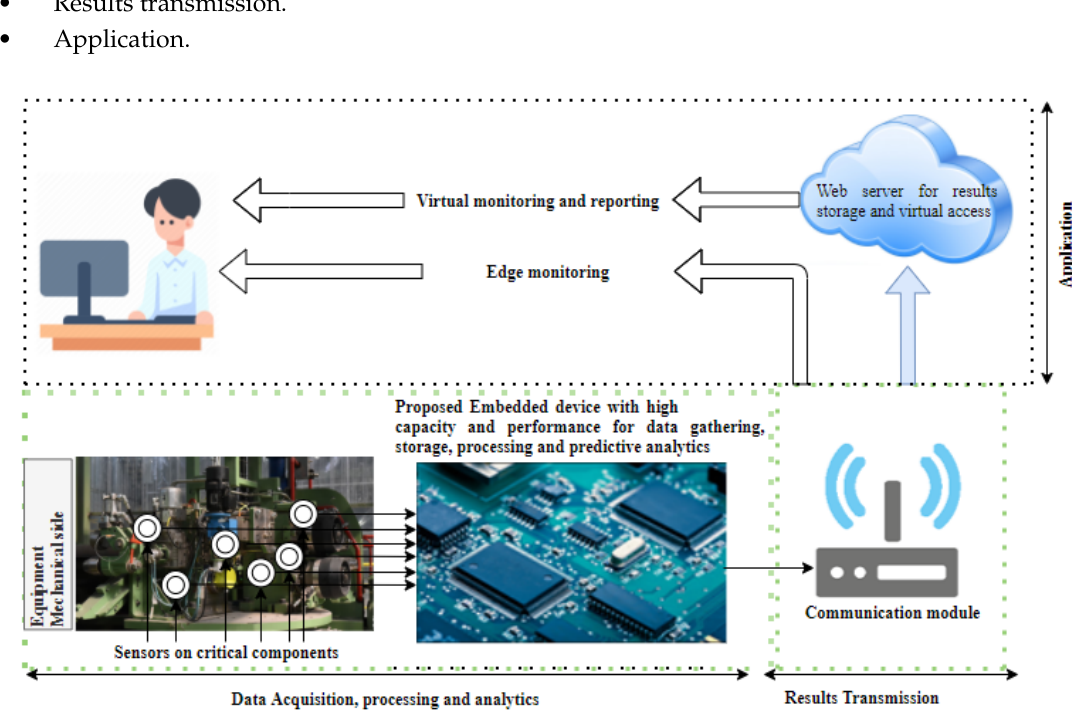
Figure 10. Proposed PdM structure using